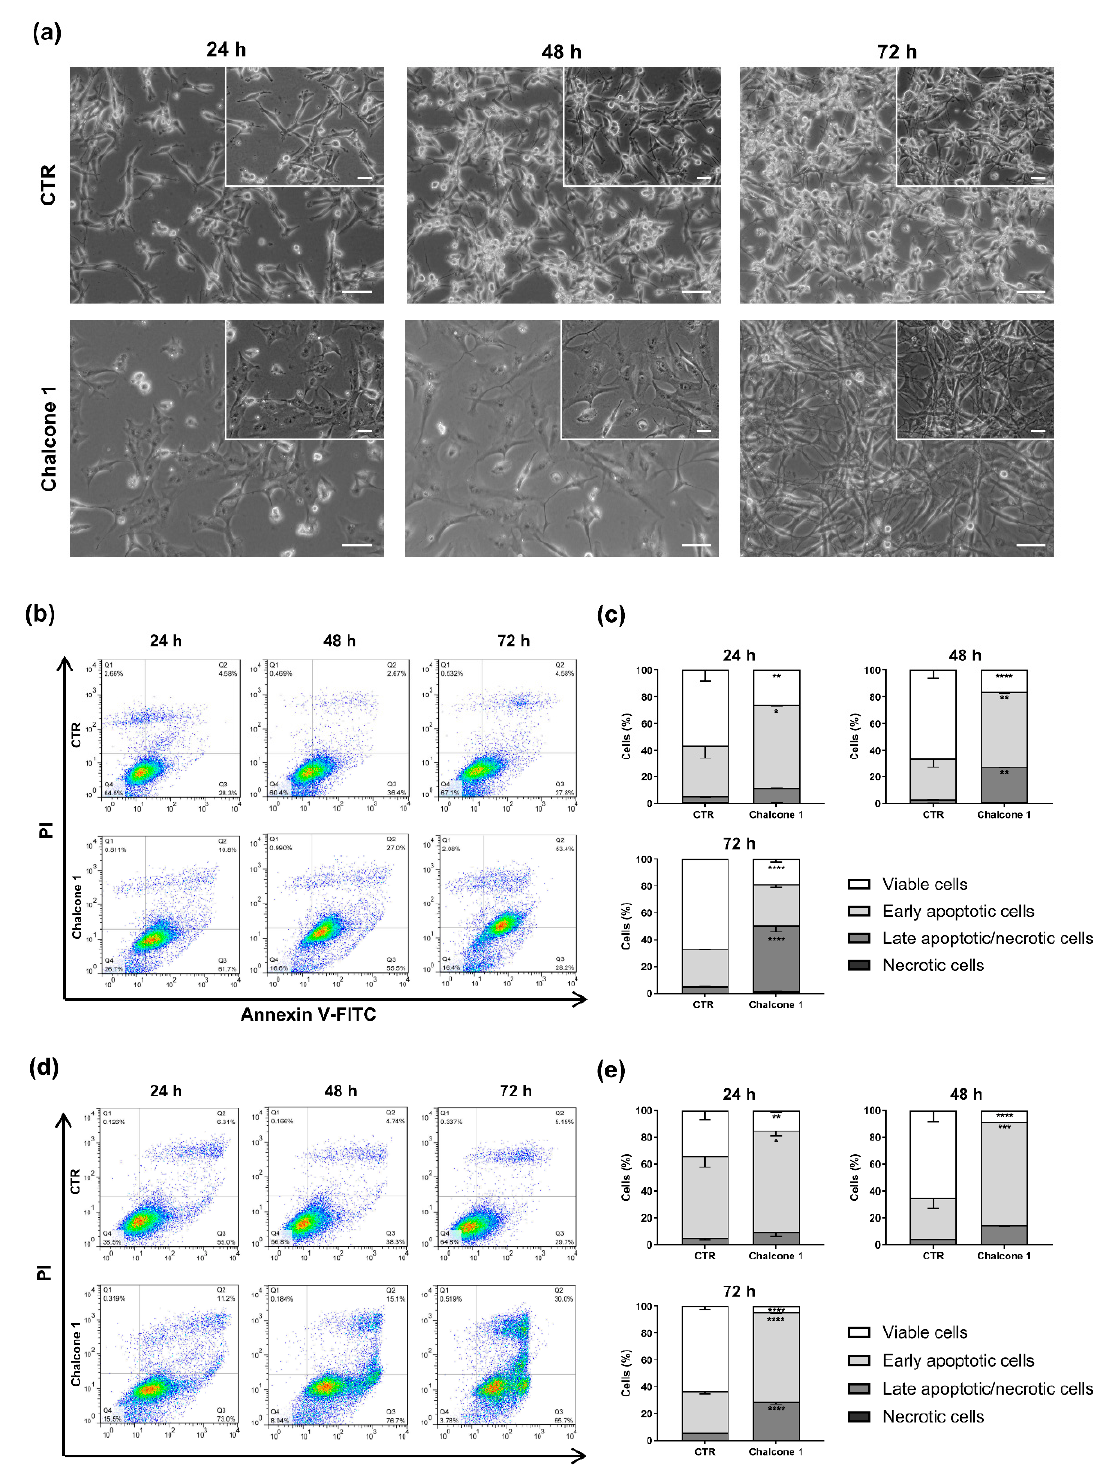
Figure 4. Cell death analyses after treatment with chalcone 1 . Morphological analyses of U87 cells without (control—CTR) and after treatment with chalcone 1 with the concentrations of the 24 h IC 50 for 24, 48, and 72 h ( a ). Flow cytometry analyses of U87 ( b ) and GL261 ( d ) cell viability at different treatment times with chalcone 1 24 h IC 50 concentrations. Graphical representation of the percentage of U87 ( c ) and GL261 ( e ) cells in each quadrant of the dot plot. Results are presented as mean ± SD of three independent experiments. * p < 0.05, ** p < 0.01, *** p < 0.001, **** p < 0.0001 compared to